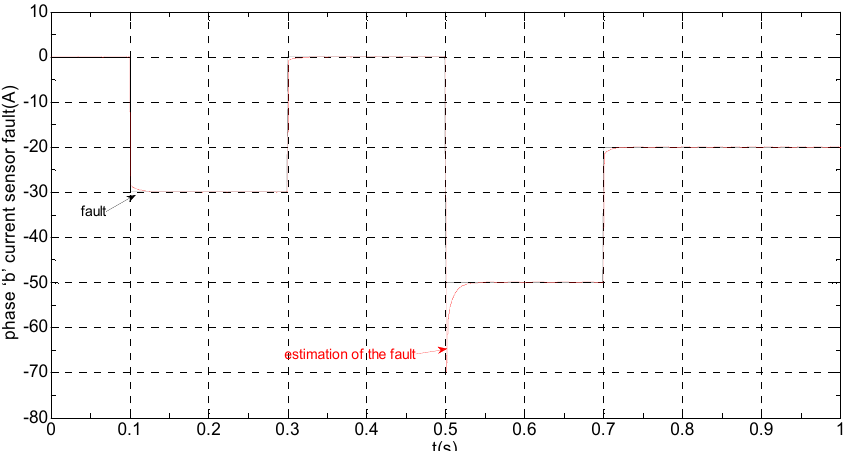
Figure 7. The current sensor fault and its reconstruction in phase “b”.